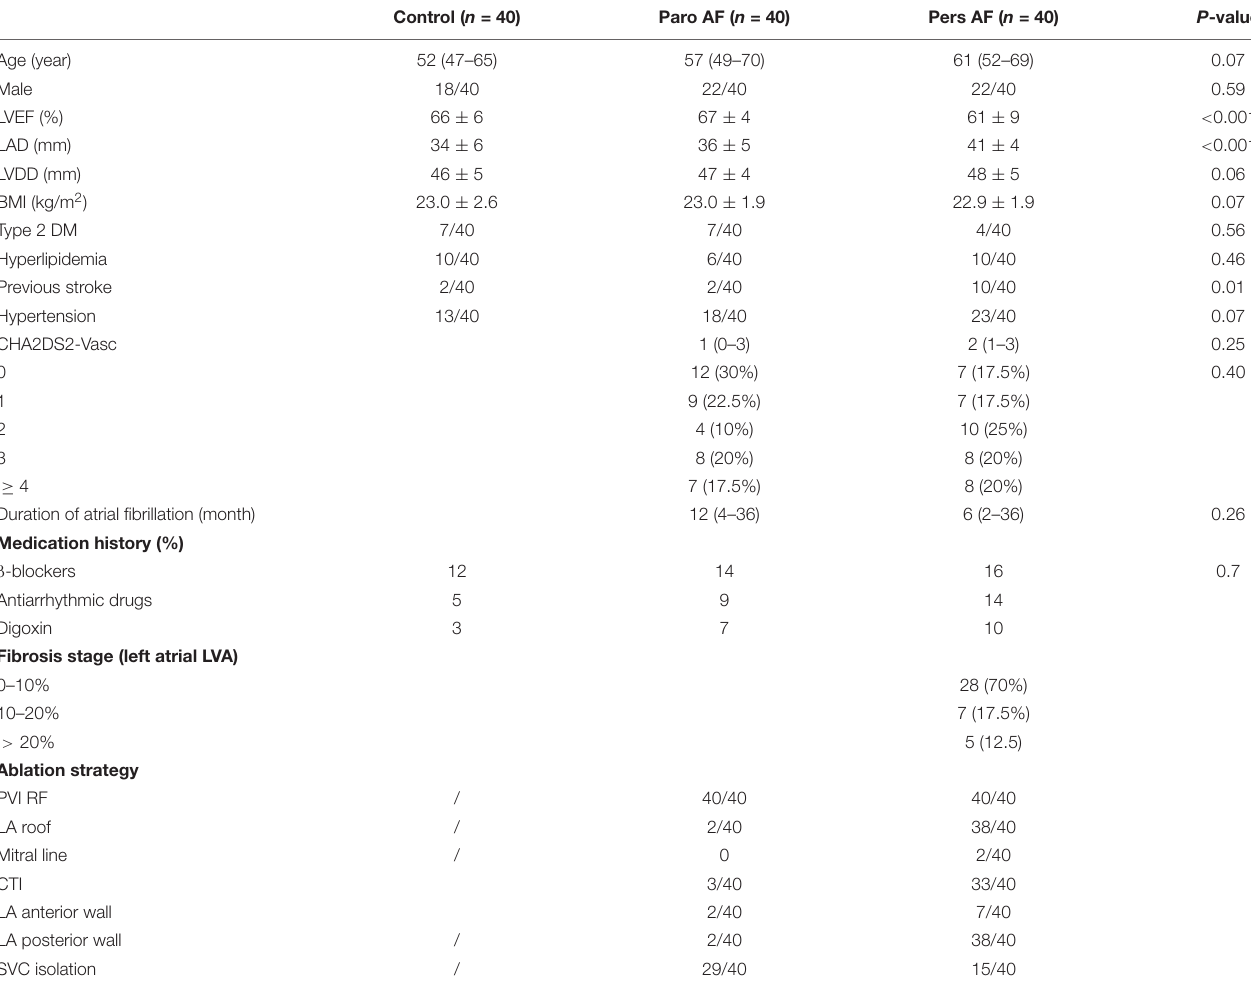
TABLE 2 | Baseline characteristics of the AF and